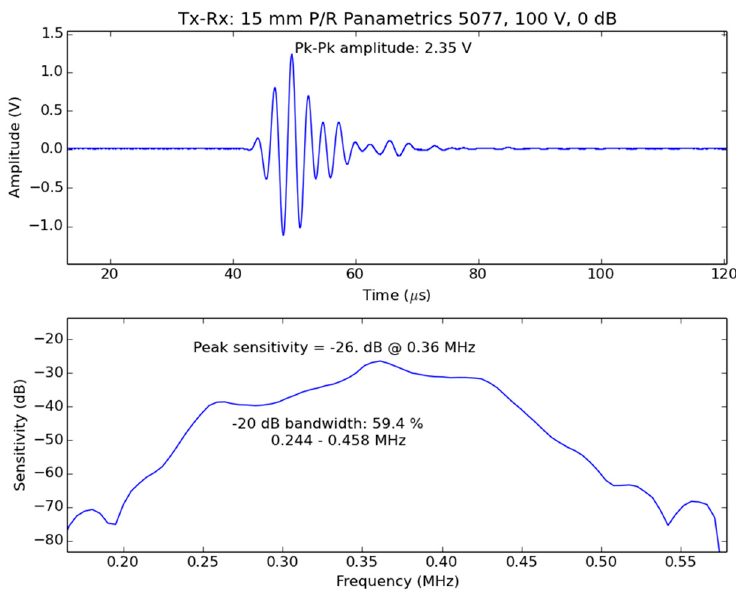
Figure 10. Response of the Tx-Rx pair for Coffea arabica leaves in through transmission. Upper figure: time domain response. Lower figure: sensitivity band.